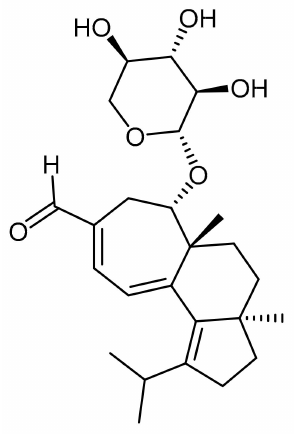
Figure 1. Chemical structure of erinacine A. Chemical Formula: C 25 H 36 O 6 (432.5 g /